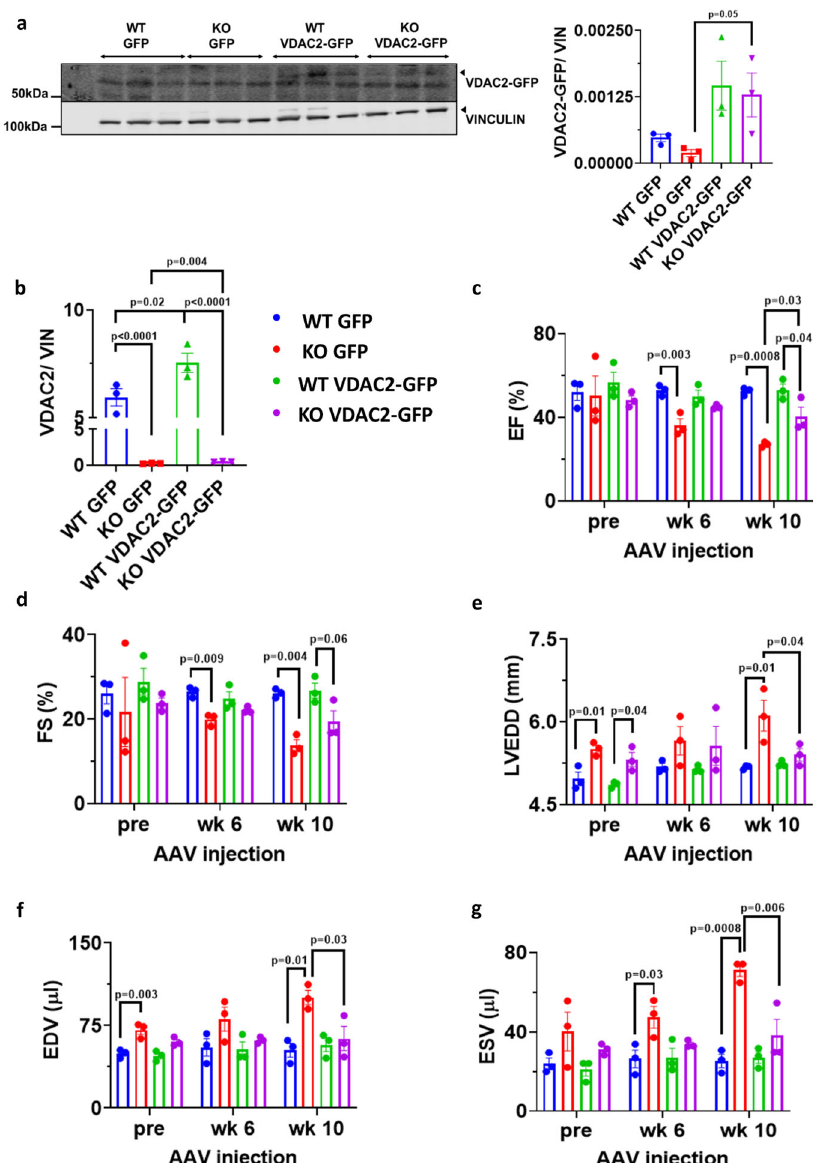
Fig. 8 Partial rescue of HF phenotype upon VDAC2 reintroduction. a Western blot image of VDAC2-GFP and lane-loading control VINCULIN and quanti fi cation using Image Studio Lite (version 5.2.5) (KO GFP vs. KO VDAC2-GFP p = 0.0568) ( n = 3); b qRT-PCR of Vdac2 normalized to Vcl (Vinculin) (KO GFP vs. KO VDAC2-GFP p = 0.0044) ( n = 3); c – g Serial echocardiography parameter including ejection fraction (EF) (week 6: WT GFP vs. KO GFP p = 0.0036, week 10: WT GFP vs. KO GFP p = 0.0008, WT VDAC2-GFP vs. KO VDAC2-GFP p = 0.0456, KO GFP vs. KO VDAC2-GFP p = 0.0359), fractional shortening (FS) (week 6: WT GFP vs. KO GFP p = 0.0091; week 10: WT GFP vs. KO GFP p = 0.0043, WT VDAC2-GFP vs. KO VDAC2-GFP p = 0.0652), left ventricular end diastolic diameter (LVEDD) (pre: WT GFP vs. KO GFP p = 0.0169, WT VDAC2-GFP vs. KO VDAC2-GFP p = 0.0407; week 10: WT GFP vs. KO GFP p = 0.0107, KO GFP vs. KO VDAC2-GFP p = 0.0444), end diastolic and end systolic volumes (EDV (pre: WT GFP vs. KO GFP p = 0.0032; week 10: WT GFP vs. KO GFP p = 0.0104, KO GFP vs. KO VDAC2-GFP p = 0.0378) and ESV (week6: WT GFP vs. KO GFP p = 0.03, week 10: WT GFP vs. KO GFP p = 0.0008, KO GFP vs. KO VDAC2-GFP p = 0.0066)) respectively ( n = 3). p -value: unpaired t -test performed in all